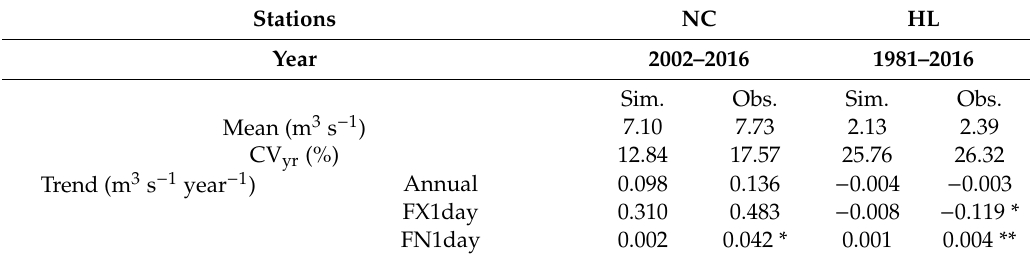
Table 5. Mean annual, variability, and annual trends of streamflow at NC and HL in the overlapping periods of simulation and